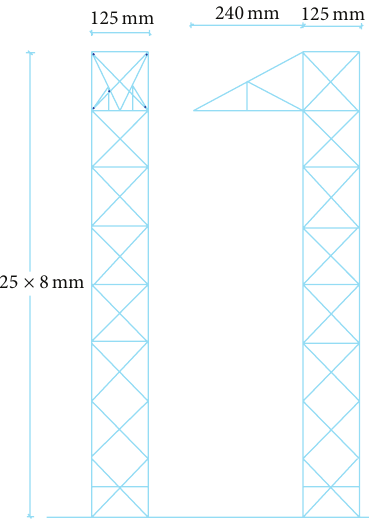
Figure 6: Dimension of studied tower 1.